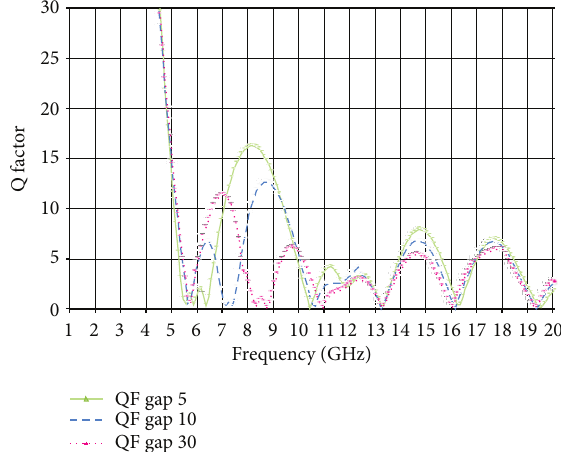
F 14: Q factor of the antenna when the gap between electrodes